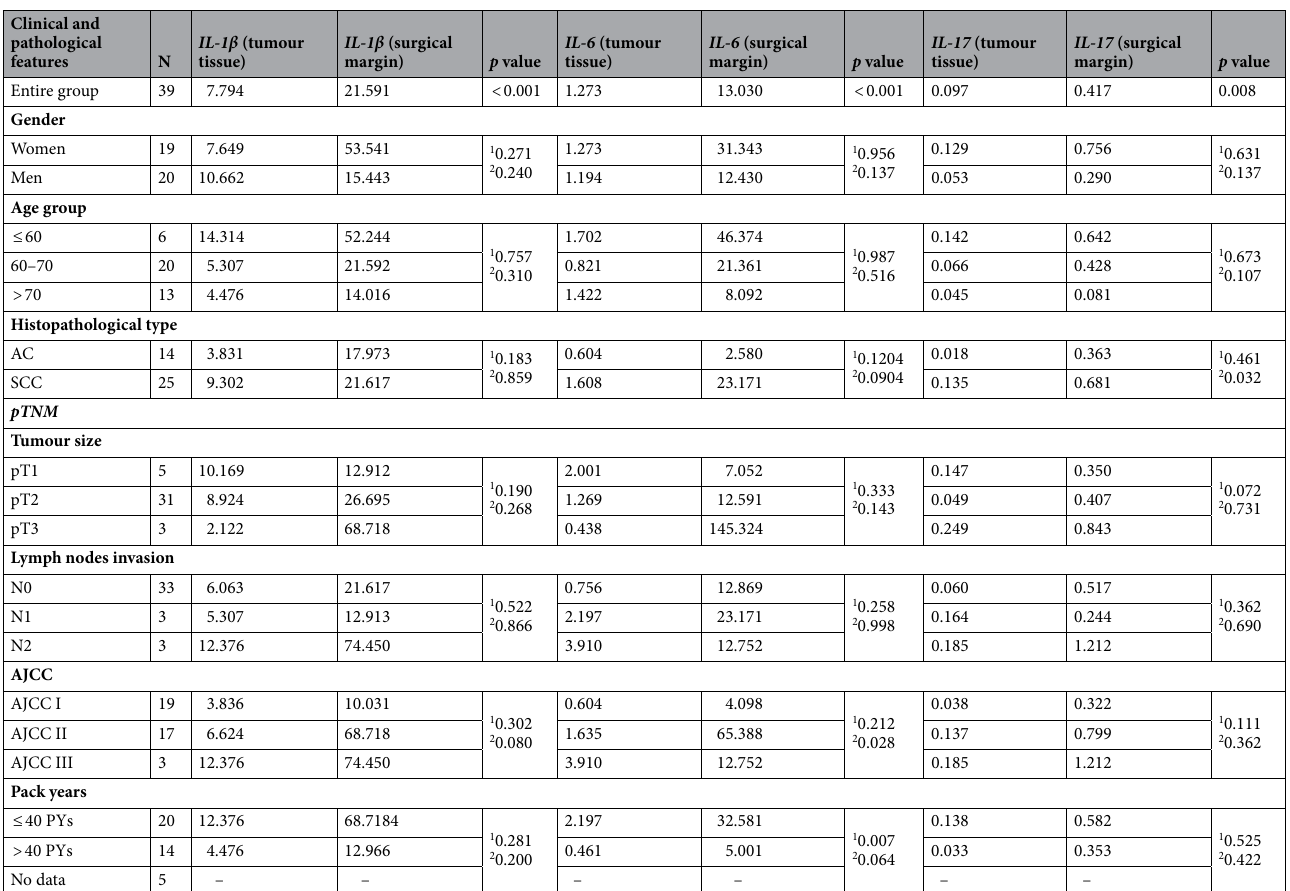
Table 1. Clinical and pathological features: median of expression level (RQ value) of evaluated genes. 1 Pertain to expression in tumour tissue. 2 Pertain to expression in surgical